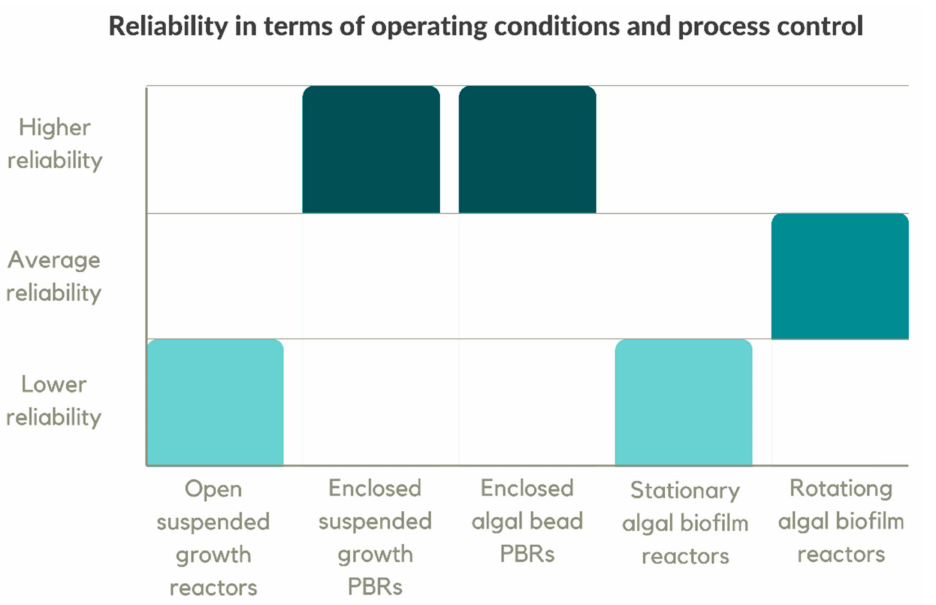
Figure 9. Reliability of the available algae-based wastewater treatment reactor configurations in terms of maintenance of stable operating conditions and process